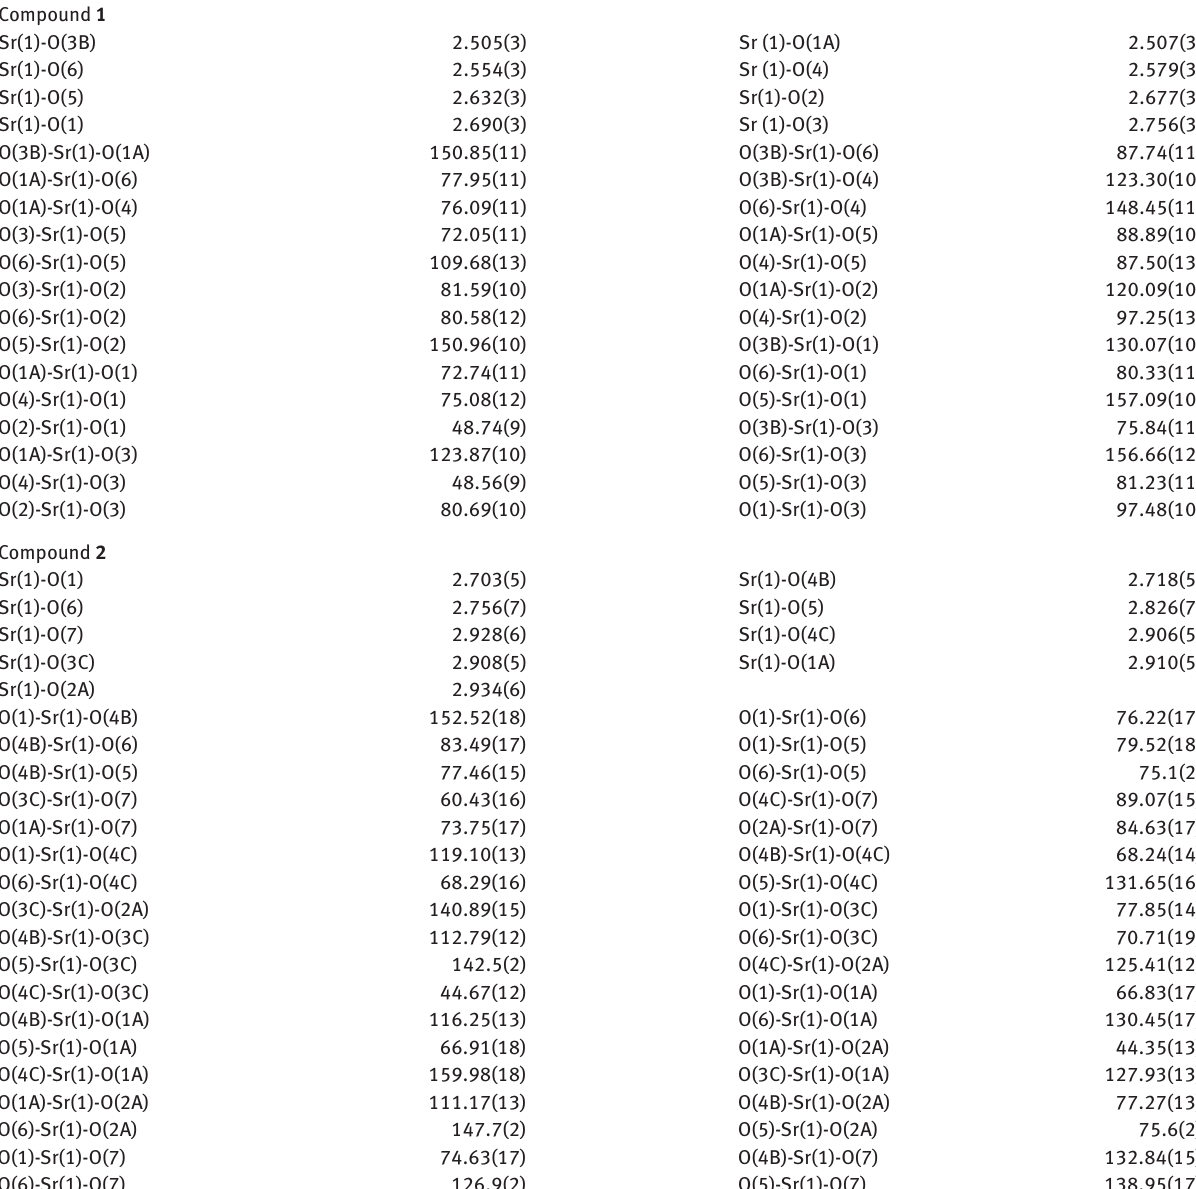
Table 2: Selected bond distances and angles for compounds 1 and 2 (Å/ °